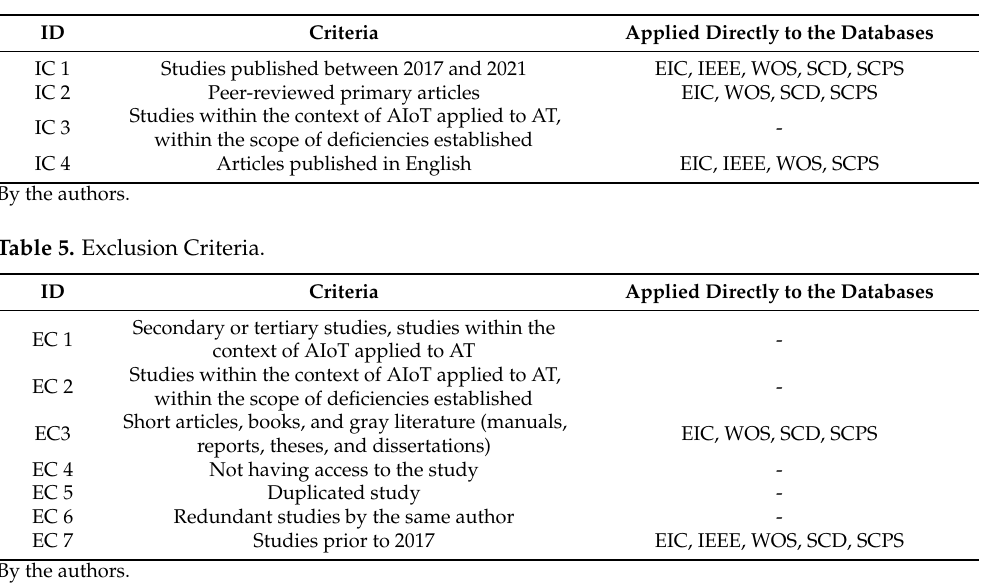
Table 4. Inclusion criteria.